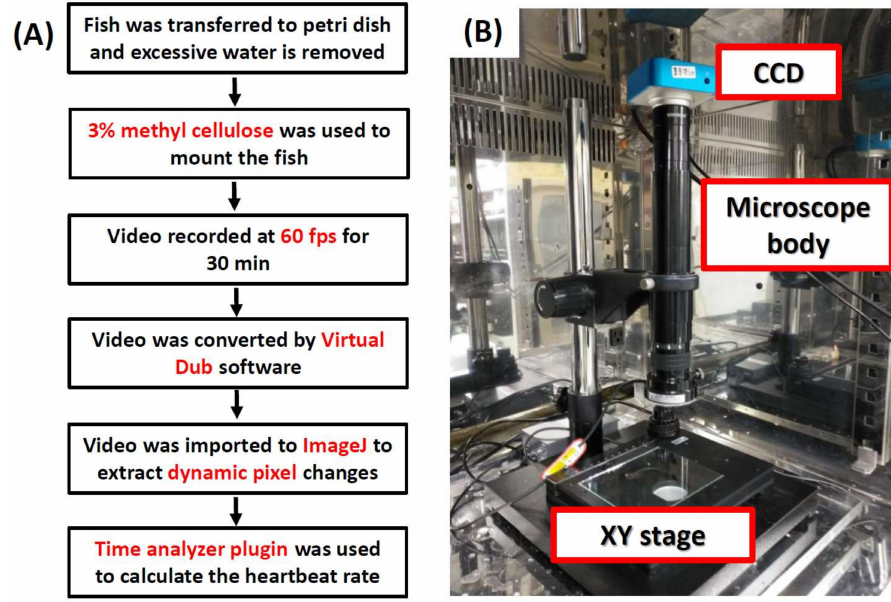
Figure 1. The equipment setting and analysis pipeline to detect cardiac rhythm in zebrafish embryos. ( A ) flowchart of analyzing cardiac rhythm in zebrafish embryos by using the dynamic pixel change method. Software Adobe Premiere, VirtualDub, ImageJ, Microsoft Excel, GraphPad Prism6 and Origin 9.1 were applied in our assay; ( B ) to avoid temperature fluctuation during the experiment, one dissecting microscope mounted with a Charge-coupled Device (CCD) was installed in a temperature controlled